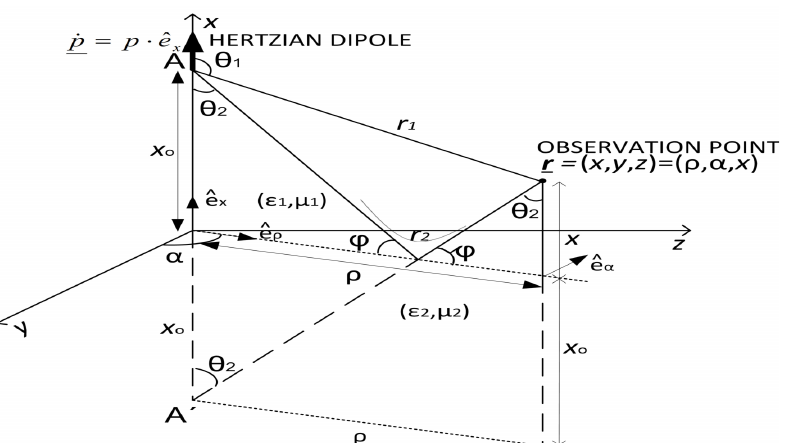
Figure 1. Hertzian dipole above an infinite, planar interface. Point A (cid:48) is the image of the source A with respect to the ground ( yz -plane); r 1 and r 2 are the distances between the observation point and the source and its image, respectively; θ 2 is the “angle of incidence” at the so-called “specular point”, i.e., the point of intersection between the ground and the line connecting the image point with the observation point; and finally, ϕ = π /2 − θ 2 is the so-called “grazing